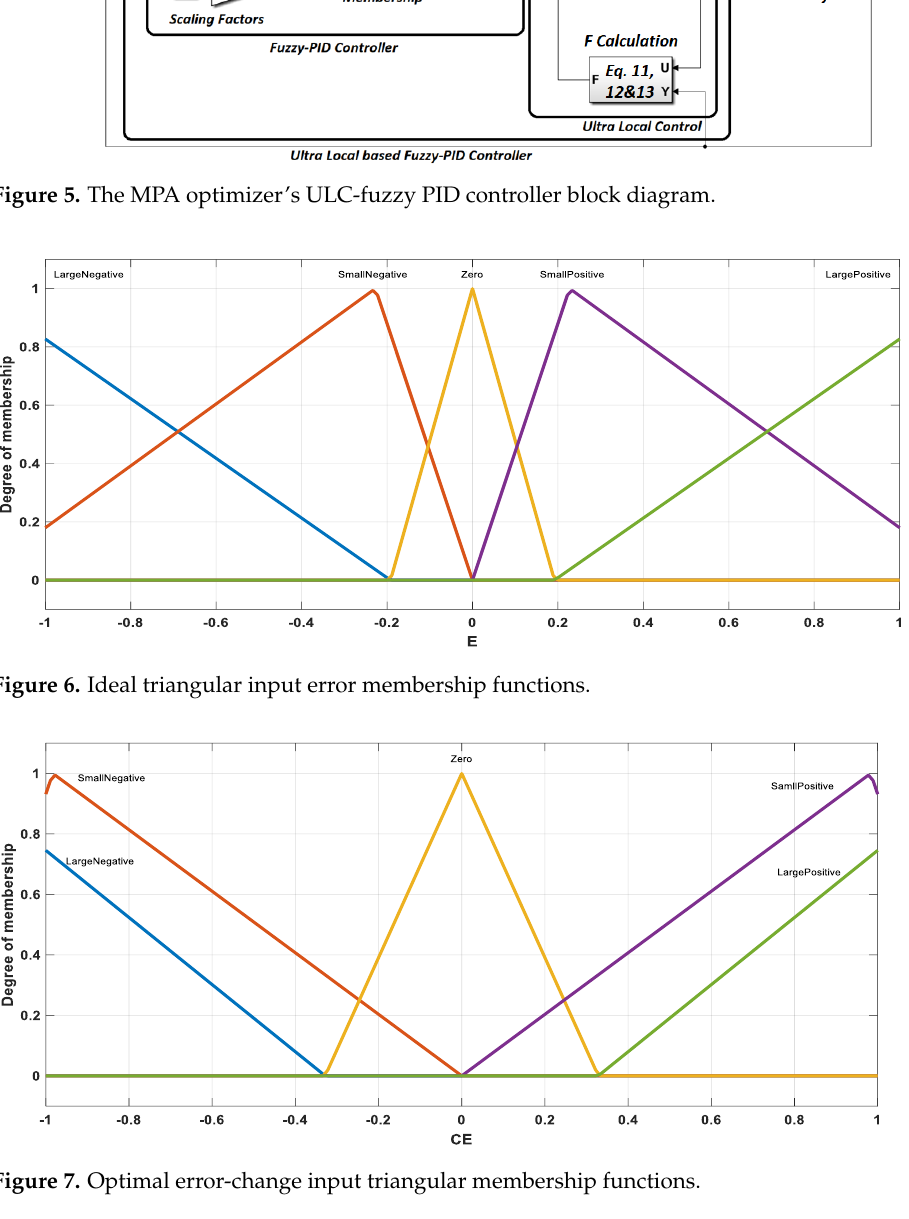
Figure 7. Optimal error-change input triangular membership functions.